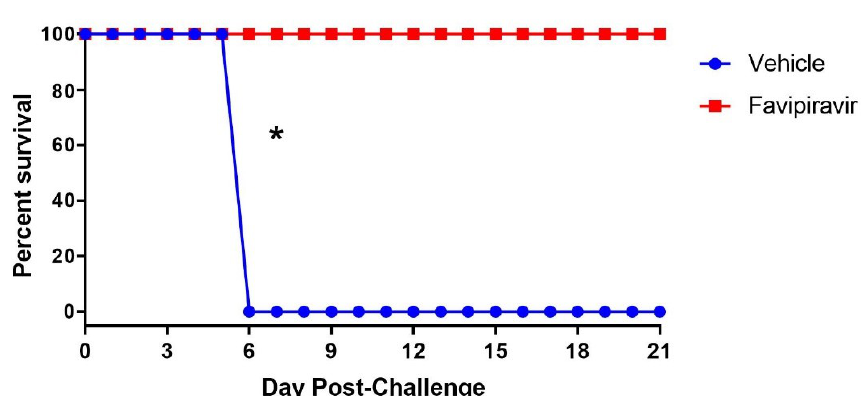
Figure 7. Efficacy of Favipiravir against SUDV in STAT-1 KO Mice. Mice were challenged with 1.0 × 10 2 pfu of SUDV then treated with 150 mg/kg of favipiravir twice daily for 8 days via oral gavage. The asterisk (*) indicates statistical significance ( p = 0.002, Fisher’s exact test).